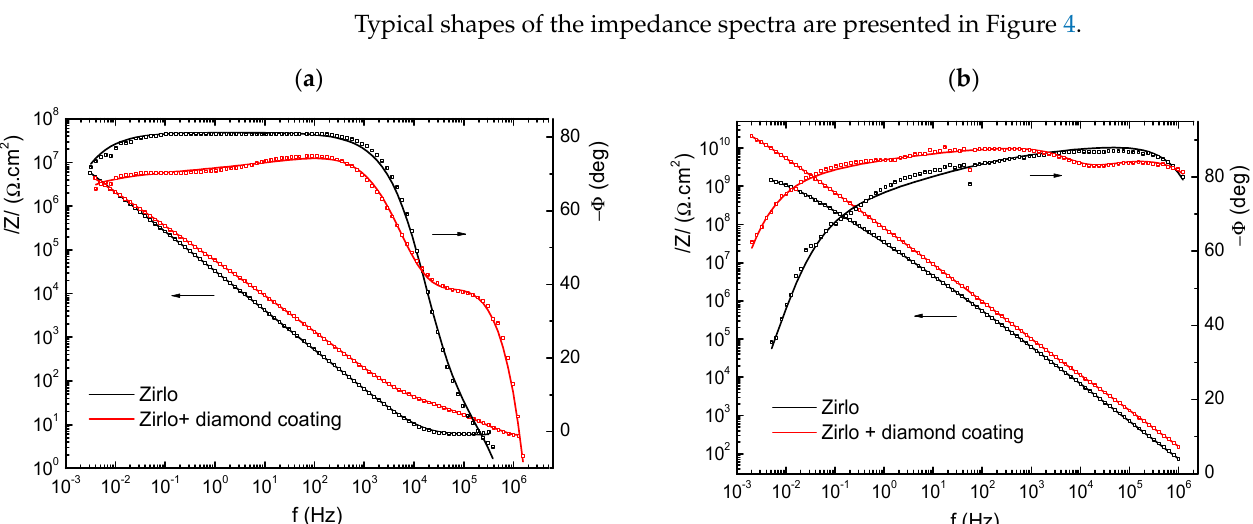
Figure 4. Bode plots of the impedance response of uncoated and diamond layer coated ZIRLO samples before ( a ) and after ( b ) exposure to steam at 850 °C.